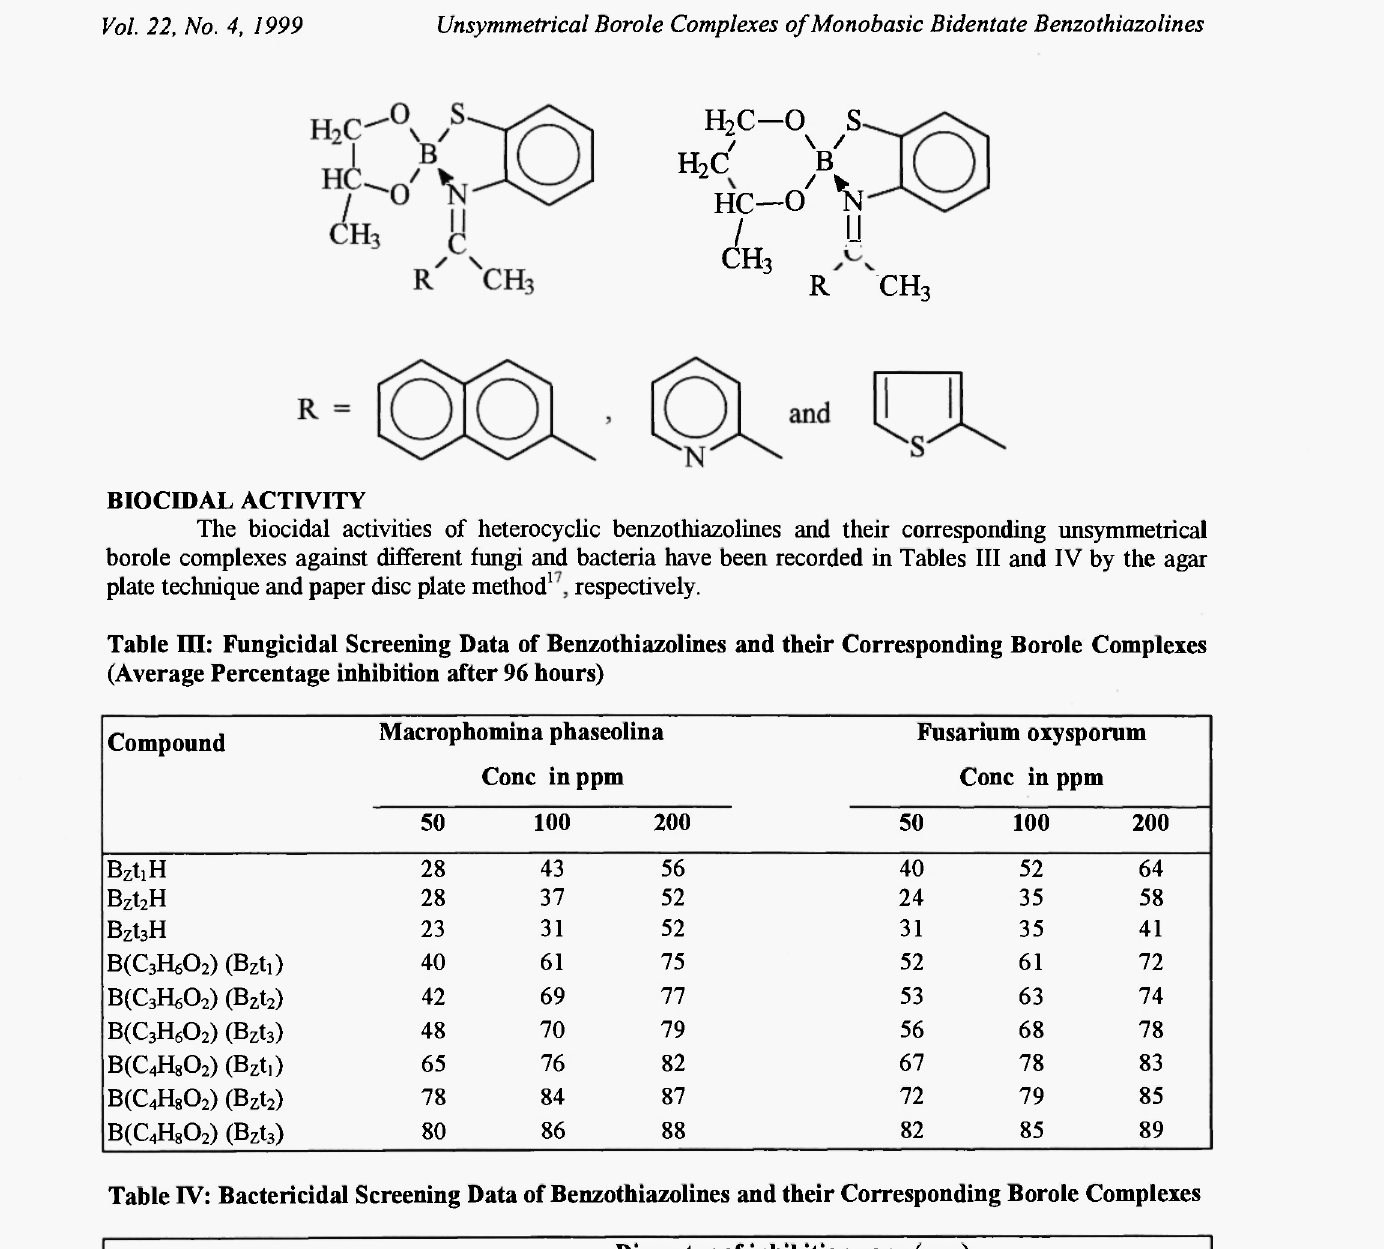
Diameter of inhibition zone (mm)